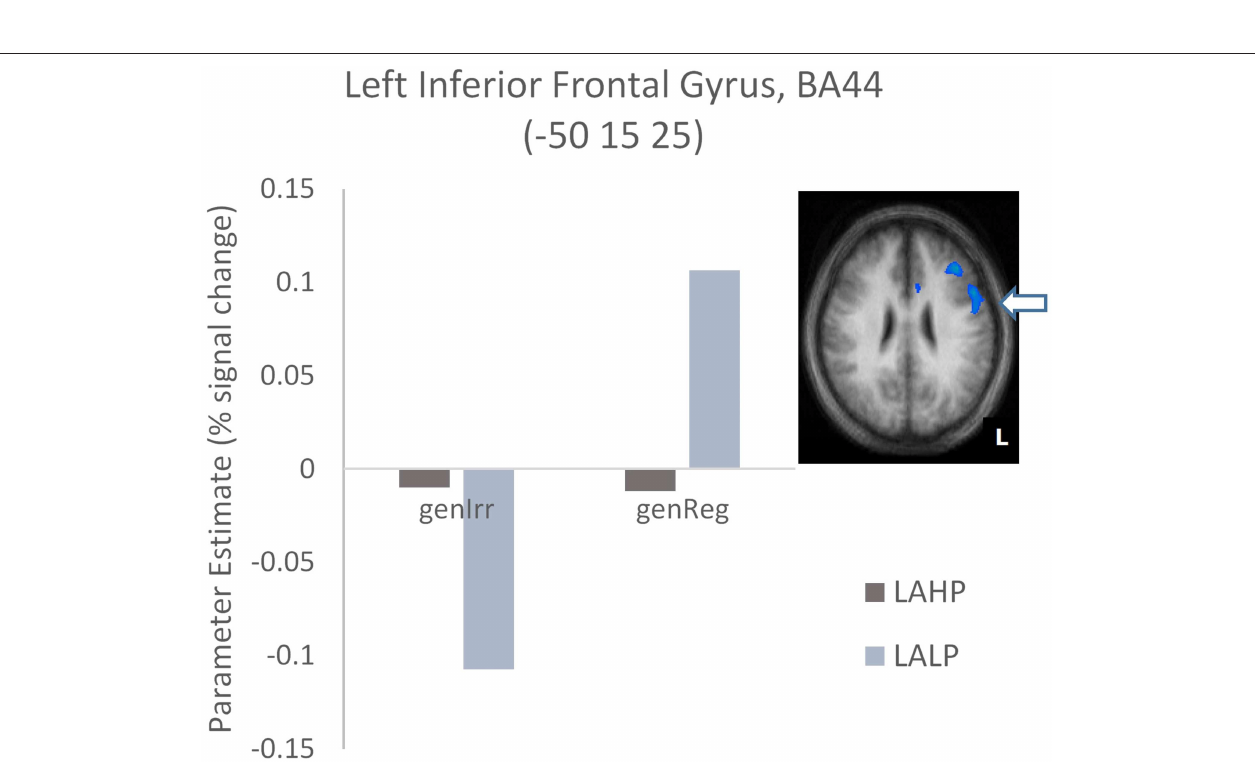
Frontiers in Communication |